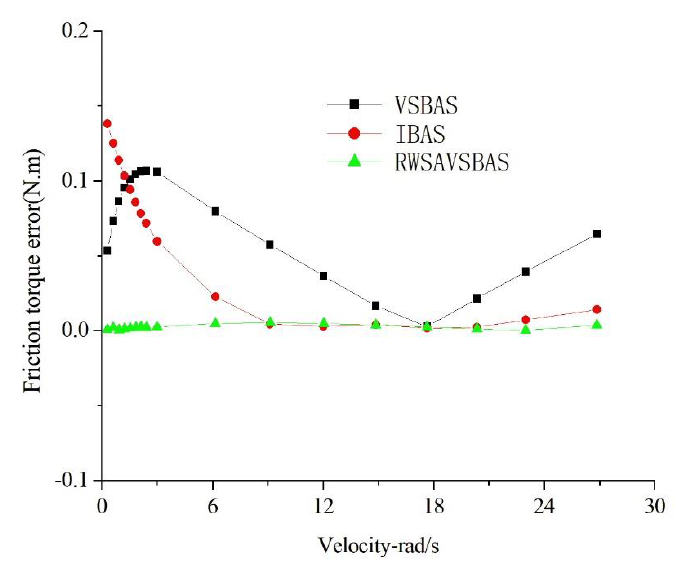
Figure 7. Comparison of minimum error of friction torque.